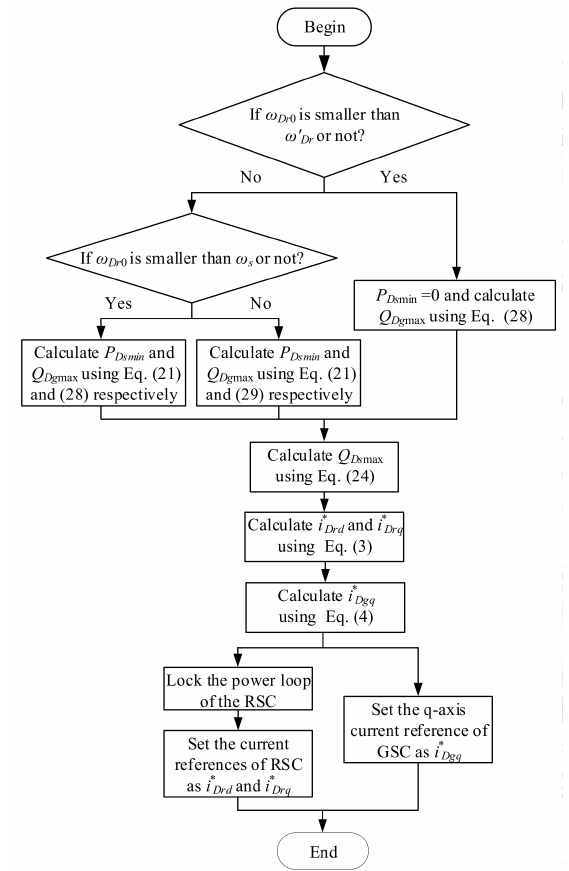
Figure 5. Flow diagram of the proposed control method of